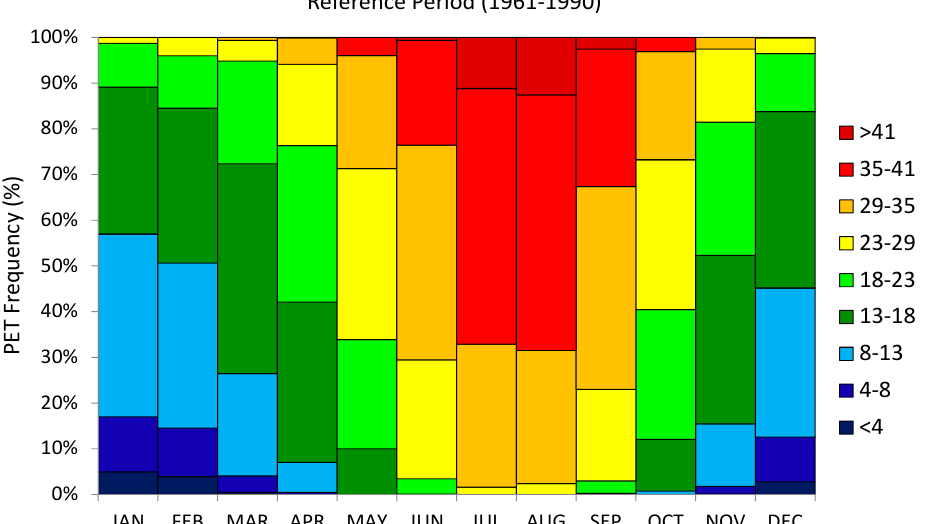
Figure 2. Bioclimate diagram for Milos island, indicating PET frequency (%) per month, for the reference period 1961–1990.